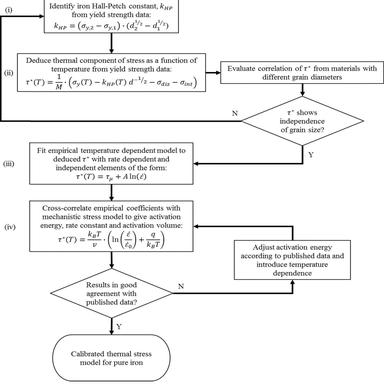
Flowchart illustrating process used to deduce model parameters for mechanistic thermal stress, based on lower yield stress data for pure iron.